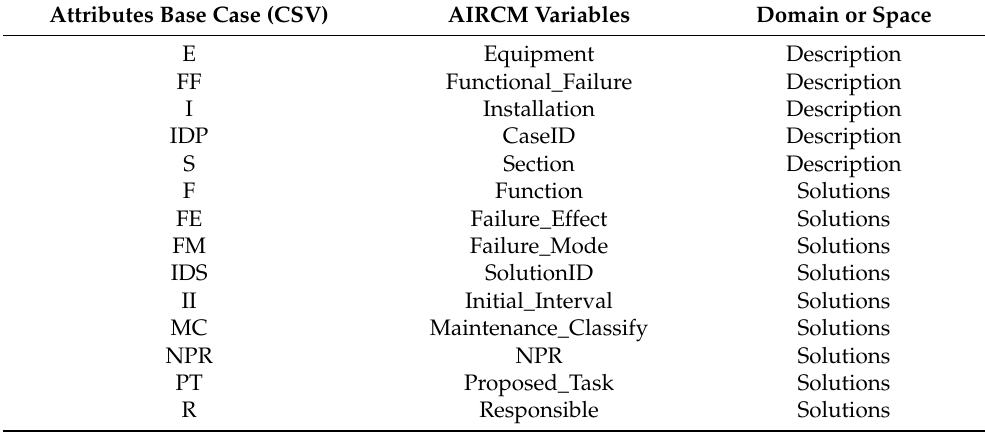
Table 2. Attributes Mapping of the Case Base and Variables implemented in the AIRCM Application.